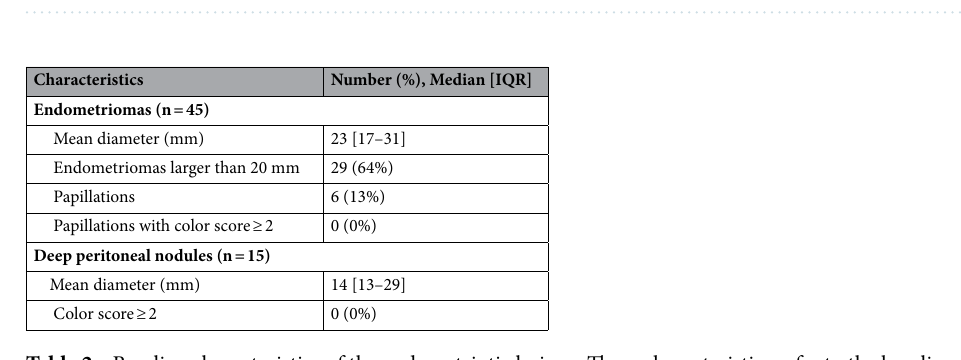
Table 2. Baseline characteristics of the endometriotic lesions. These characteristics refer to the baseline situation, i.e. before initiating the ovarian hyper-stimulation. IQR interquartile range.